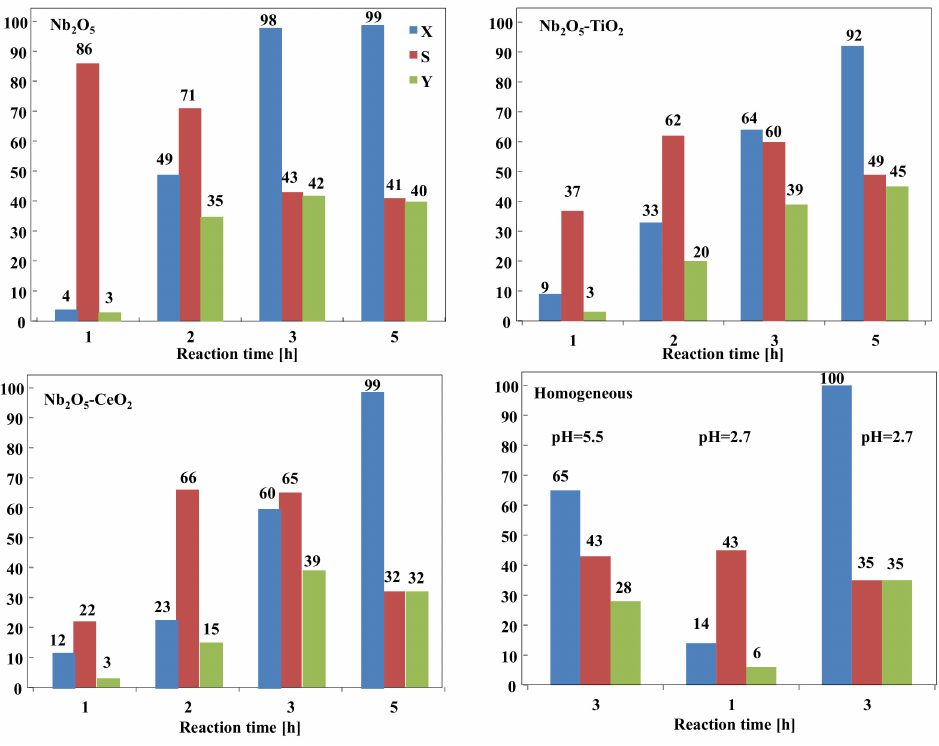
Figure 9. Fructose conversion ( X ), selectivity to HMF ( S ) and yield ( Y ) obtained in catalytic experiments carried out with an initial fructose concentration of 1 M at 165 ◦ C in the presence of 6 mL of a suspension of 2 g · L − 1 of heterogeneous catalysts or in homogeneous systems for reaction times ranging from 1 to 5 h.